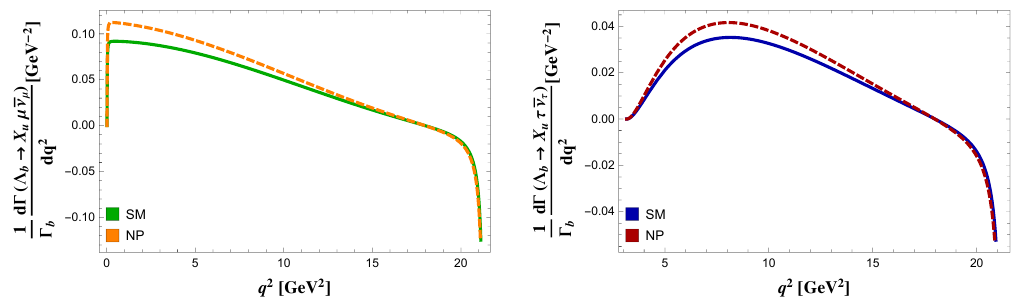
Figure 10 . q 2 distribution for (cid:3) b ! X u ‘ (cid:22) (cid:23) ‘ , with ‘ = (cid:22) (left) and ‘ = (cid:28) (right). The solid line corresponds to SM, the dashed line to NP at the benchmark point.